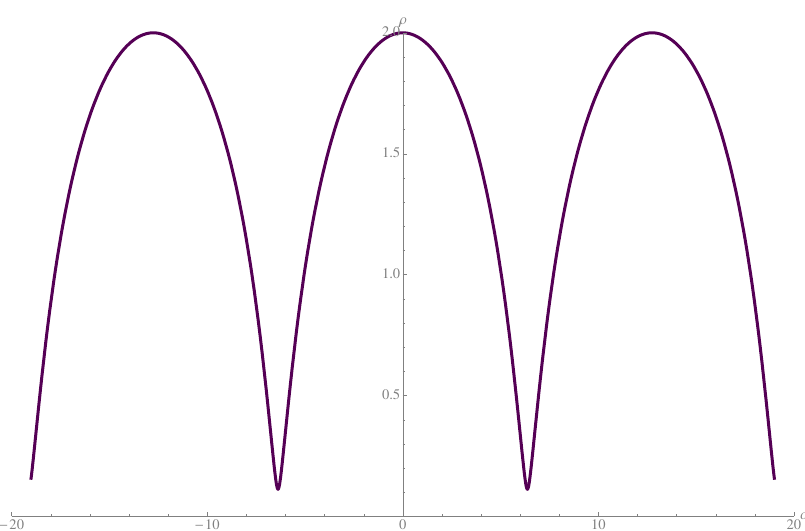
Figure 3 . The string pro(cid:12)le (cid:26) ( (cid:27) ) plotted against (cid:27) for q = 1, i.e pure NS (cid:13)ux